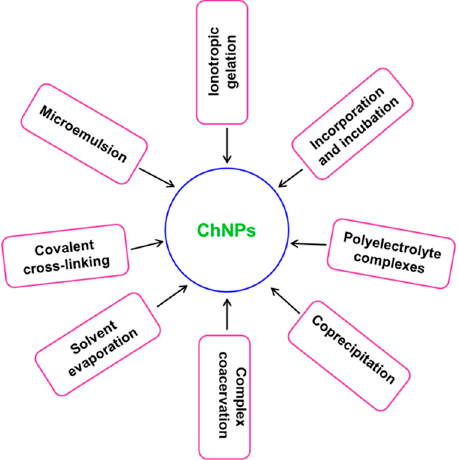
Figure 1. Schematic illustration of different methods of chitosan nanoparticle (ChNP) synthesis. At present, ChNPs are usually synthesized using a bottom-up ionic gelation method in which a solution of an anionic cross-linker, for example, sodium tripolyphosphate (TPP), and Ch is prepared